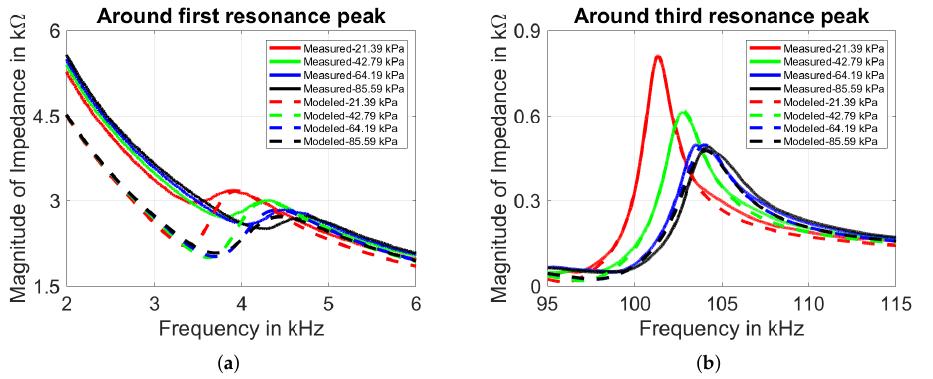
Figure 21. Influence of mechanical load on frequency dependence of PZT-27 disc around ( a ) first resonance and ( b ) third resonance